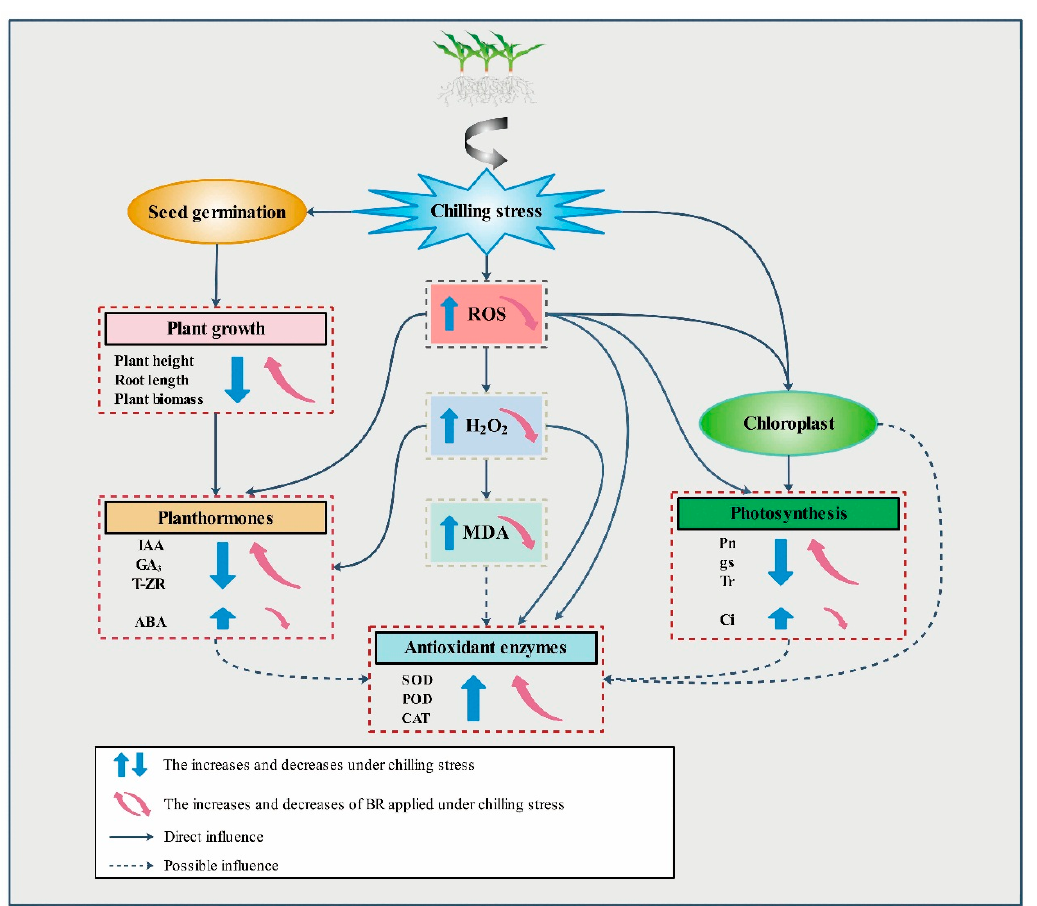
Figure 6. Probable model for BL mode of action in the maize response to chilling stress.